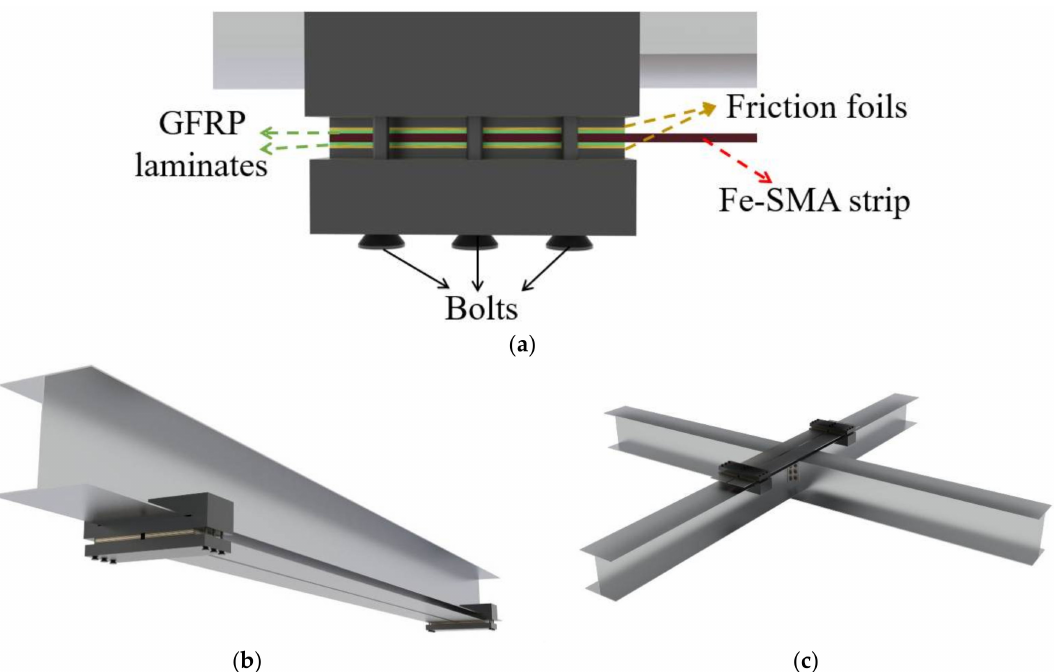
Figure 15. Schematic illustration of friction-based mechanical anchorage system for Fe-SMA strips in steel structures: ( a ) Configuration details; ( b ) Strengthening of metallic girders; and ( c ) strengthening of metallic